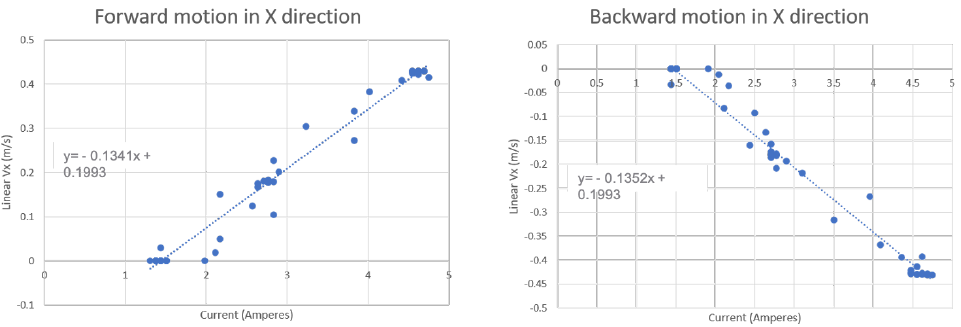
Figure 7. Relation between Current consumption and Linear Vx for the cleaning robot.